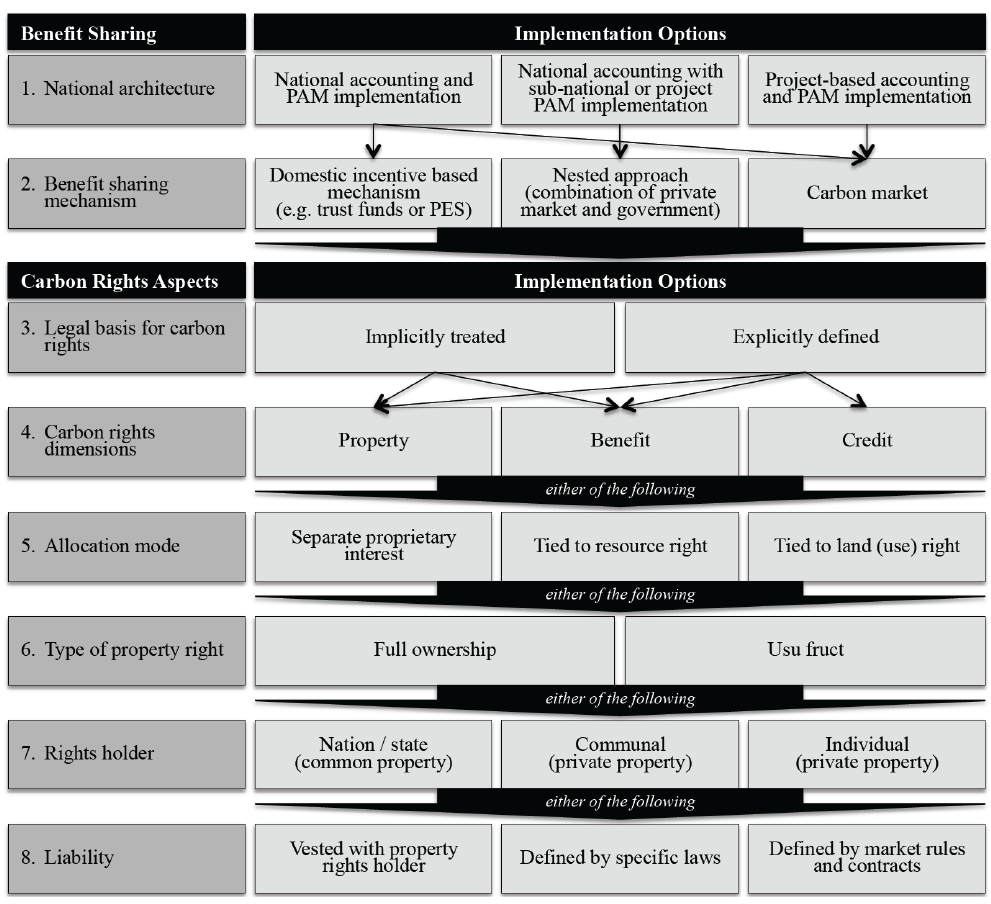
Figure 1. Framework for the assessment of national carbon rights